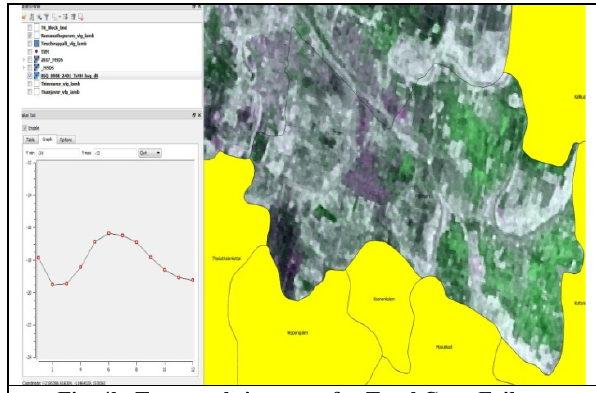
Fig. 4b. Temporal signature for Total Crop Failure Backscattering signature for crop field were generated using the dB stack derived from 11 date SAR images and the date of crop failure was assessed and the villages were identified for failed sowing (within thirty days after sowing) or total crop failure (beyond 30 days) as depicted in Fig. 4. Table 3. Number of villages identified for Prevented/Failed sowing and Total crop